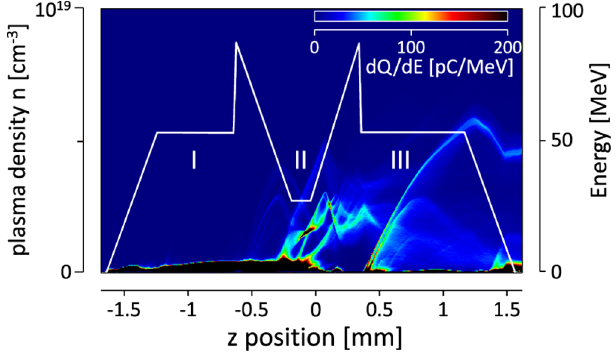
FIG. 6. Electron energy distribution as a function of the laser pulse z position and plasma density distribution (white curve).